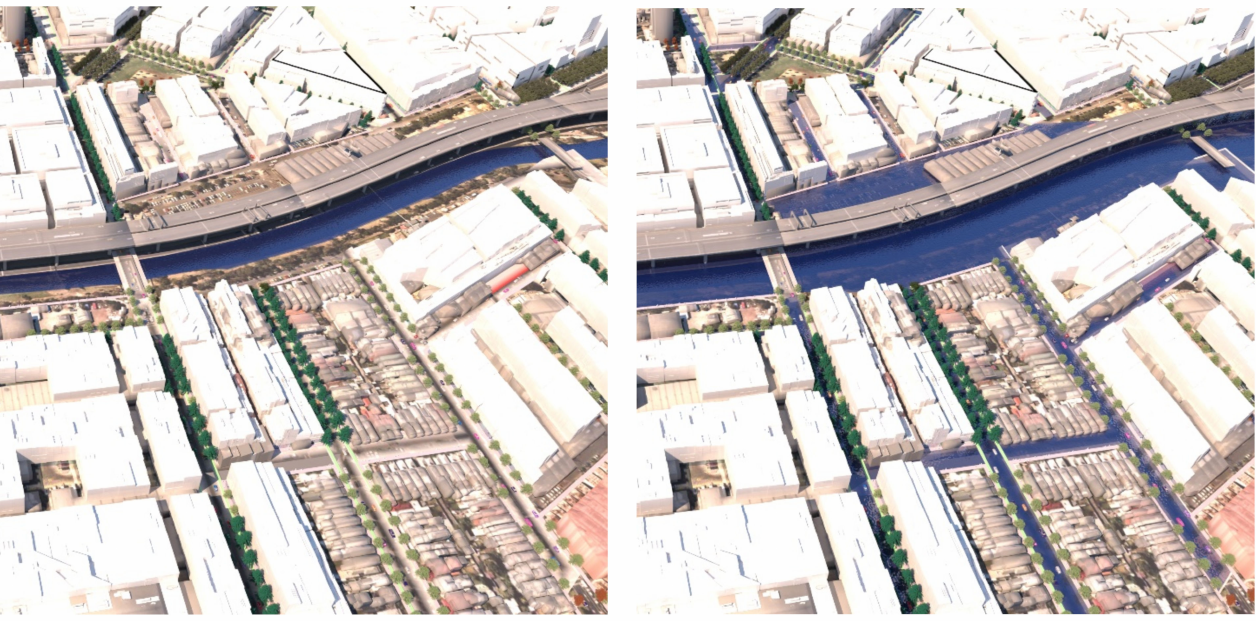
Figure 15. Detailed rendering, aerial view looking east for scenario (1) ‘Land subject to inundation’ LEFT under dry conditions and RIGHT under flood conditions. Image by authors using multi-criteria street tree design decision support modelling approach in Autodesk™ 3ds Max™.